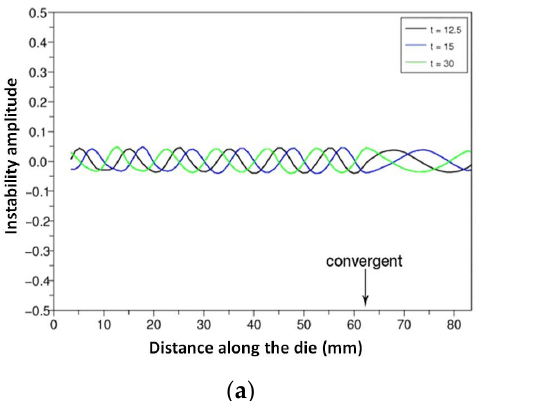
Figure 21. Propagation of an interface perturbation along the die geometry. ( a ) under stable condi- tions; ( b ) under unstable conditions (Reprinted from Ref. [38]).